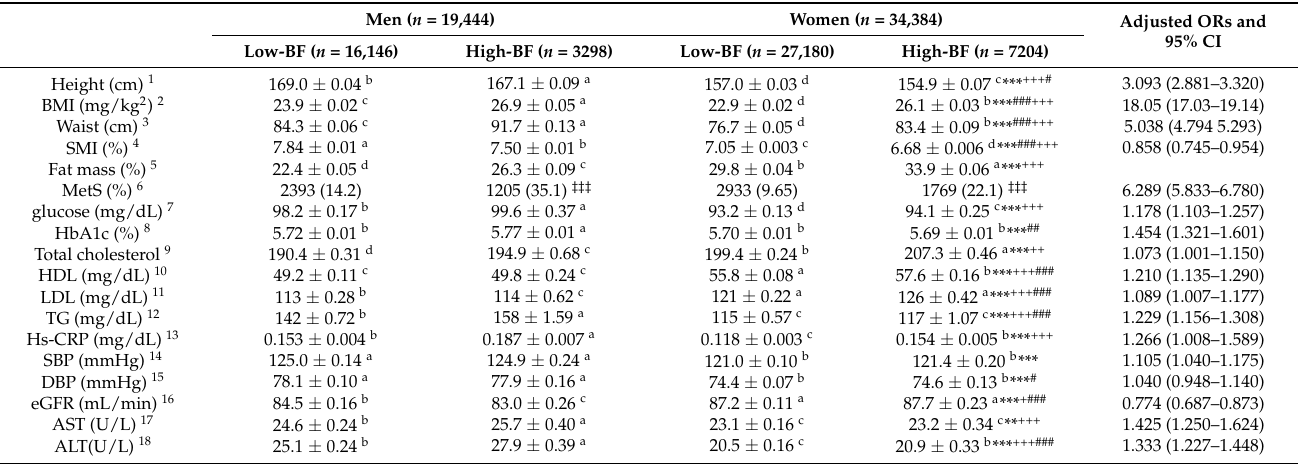
Values represent adjusted means ± standard error for continuous variables and the number and percentages of participants for categorical variables. Adjusted for age, BMI, education, income, energy intake, alcohol intake, smoking, and total activity. High body fat (case) was defined as 25% and 30% of body weight for men and women, respectively. MetS, metabolic syndrome. The cutoff points of the reference for logistic regression with adjusted for age, BMI, education, income, energy intake, alcohol intake, smoking, and total activity. They were as follows: 1 <172.5 cm for men and <160 cm for women; 2 <25 kg/m 2 for BMI; 3 <90 cm for men and 85 cm for women waist circumferences; 4 <29.0% for men and 22.8% for women in skeletal muscle index (SMI; defined as appendicular skeletal muscle mass/weight); 5 <25% for men and 30% for women for fat mass; 6